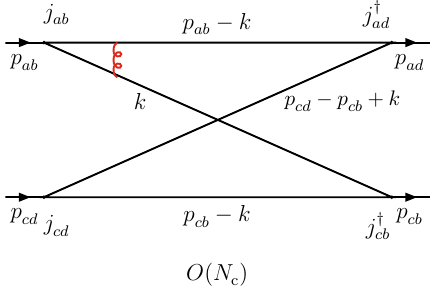
Fig. 19 One-gluon exchange between quarks a and